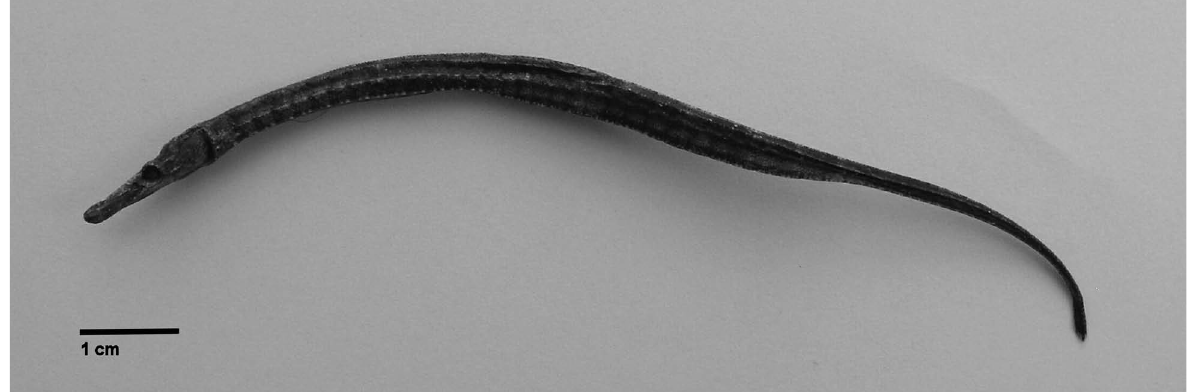
Fig. 1. Black-striped pipefish, Syngnathus abaster (TL = 114 mm) caught on 23 July 2011 in the lower Neretva River, Bosnia and